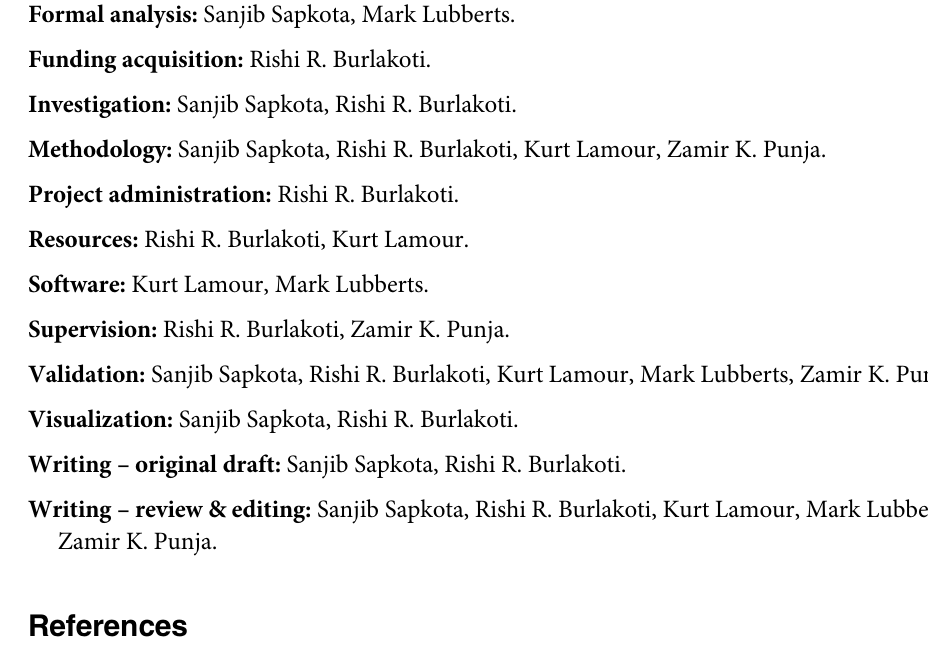
S2 Fig. Exact sequence alignment of targeted region of Phytophthora rubi (A and B) and Phytophthora gonapodyides (C and D) with Illumina sequences (multiplex targeted- sequencing) obtained from unknown samples. S1 Table. List of primers used in multiplex PCR approach of Phytophthora spp. identifica- tion. S2 Table. Summary data for multiplex targeted-sequencing of unknown isolates obtained from red raspberry infected with